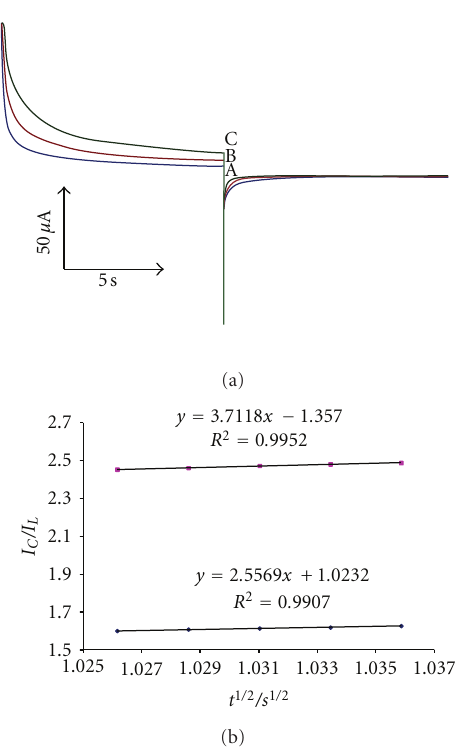
Figure 5: (a) Chronoamperograms obtained at the MMWCNTPE in the absence (A) and in the presence of (B) 250 and (C) 500 μ M Hcy in a bu ff er solution (pH 4.0). (b) dependence of I C /I L on the t 1 / 2 derived from the chronoamperogram